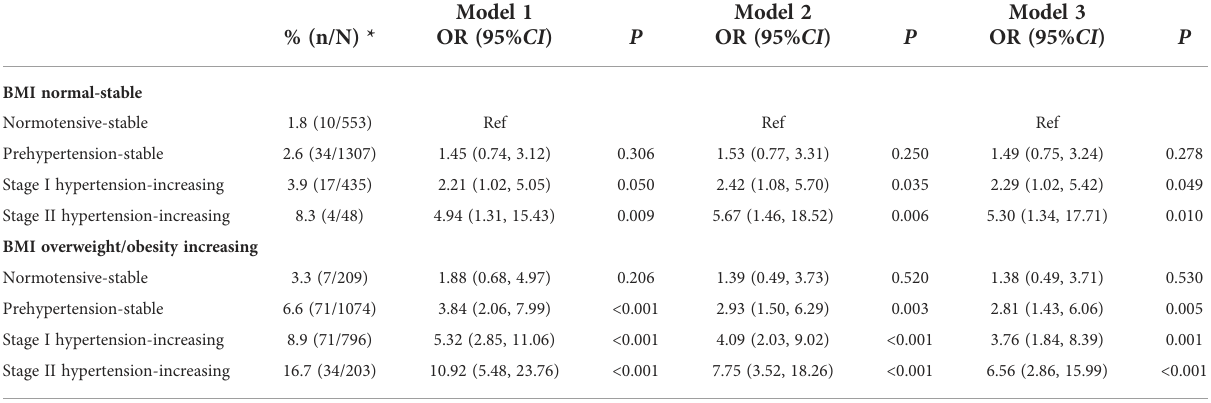
TABLE 3 Odds Ratios and 95% CIs for Joint Trajectories of SBP and BMI Groups for Incident Diabetes.